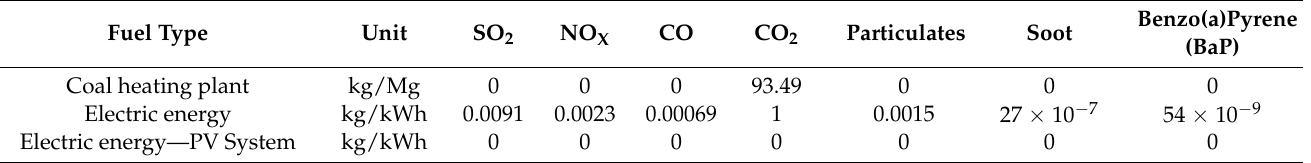
Table 1. Specific emission factors ( EF ) for different